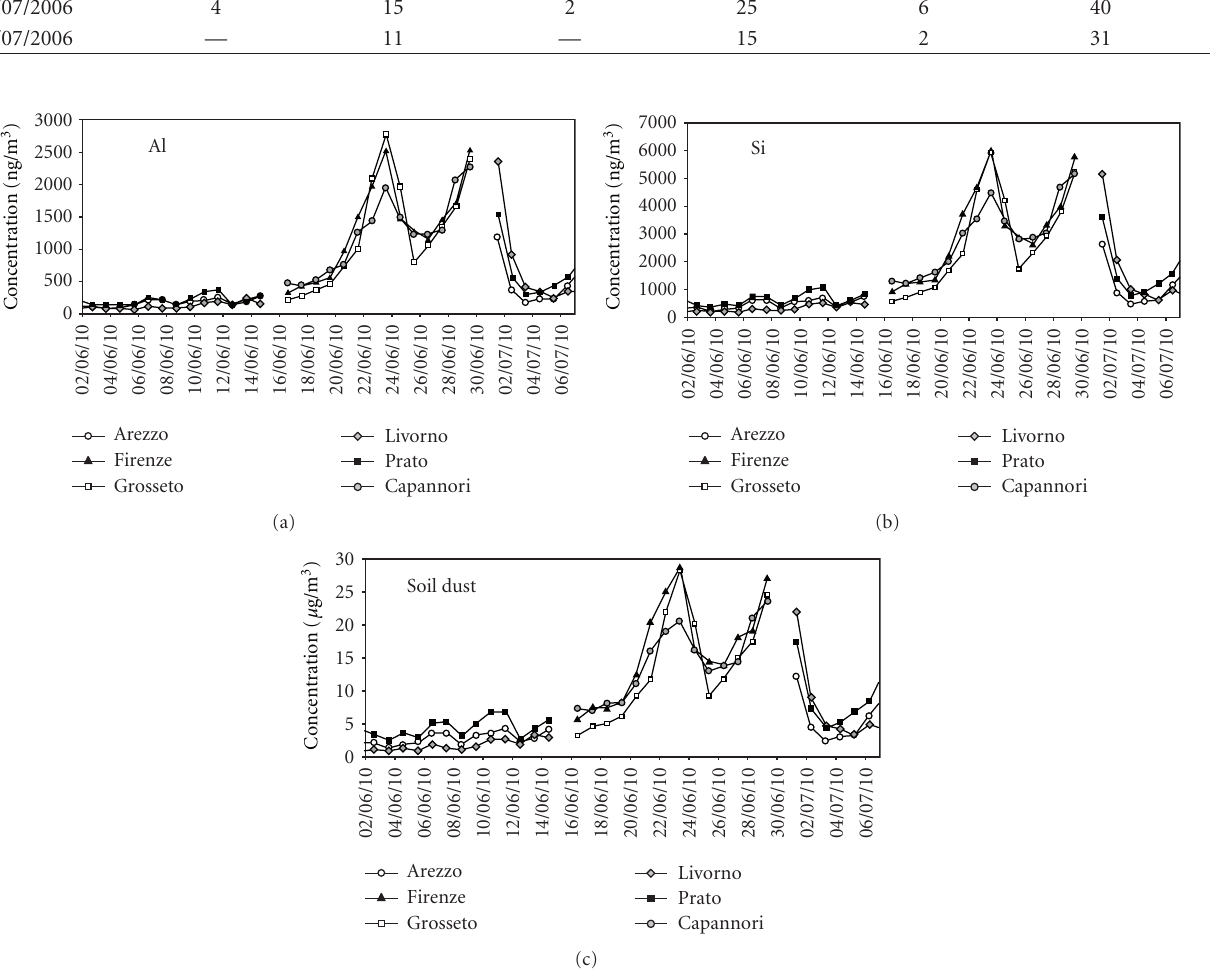
Figure 8: Daily concentrations of Al (ng/m 3 ), Si (ng/m 3 ), and soil dust ( µ g/m 3 ) in PM 10 samples collected in June 2006 in six sampling sites in Tuscany